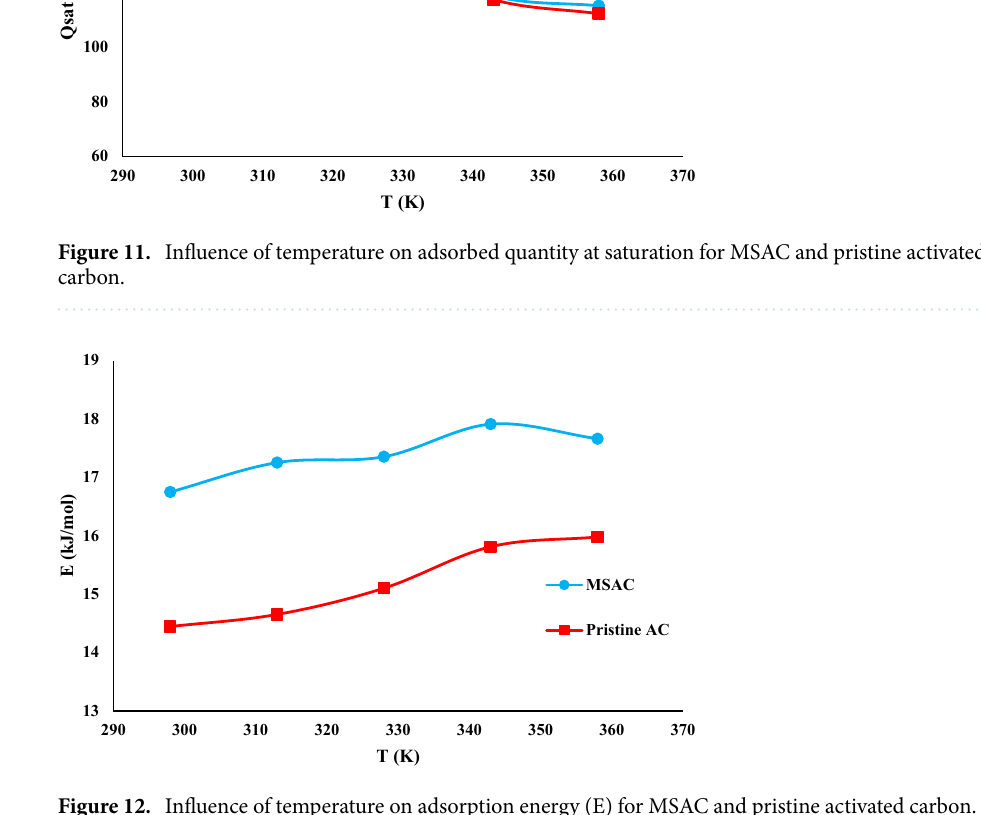
Figure 12. Influence of temperature on adsorption energy (E) for MSAC and pristine activated